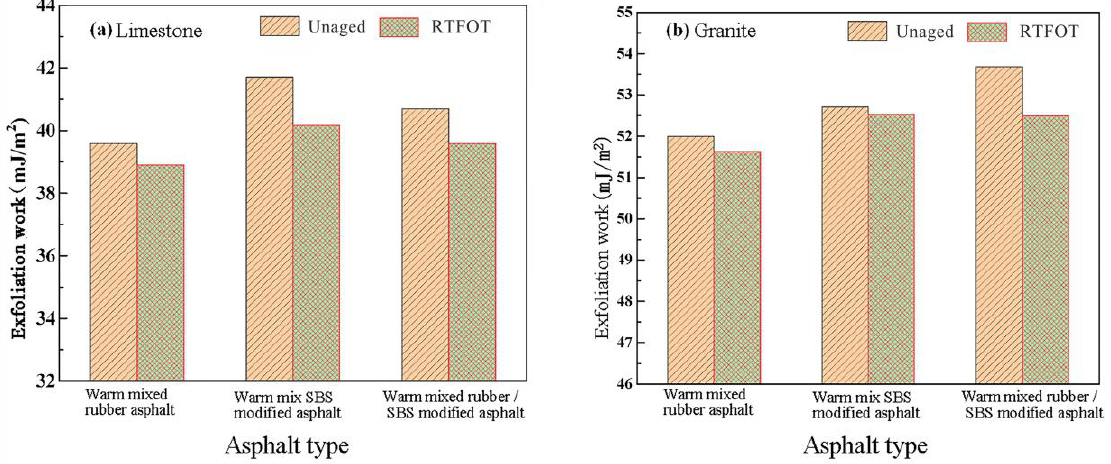
Figure 6. Peeling work of asphalt and different aggregates before and after aging: ( a ) Limestone and ( b ) Granite.